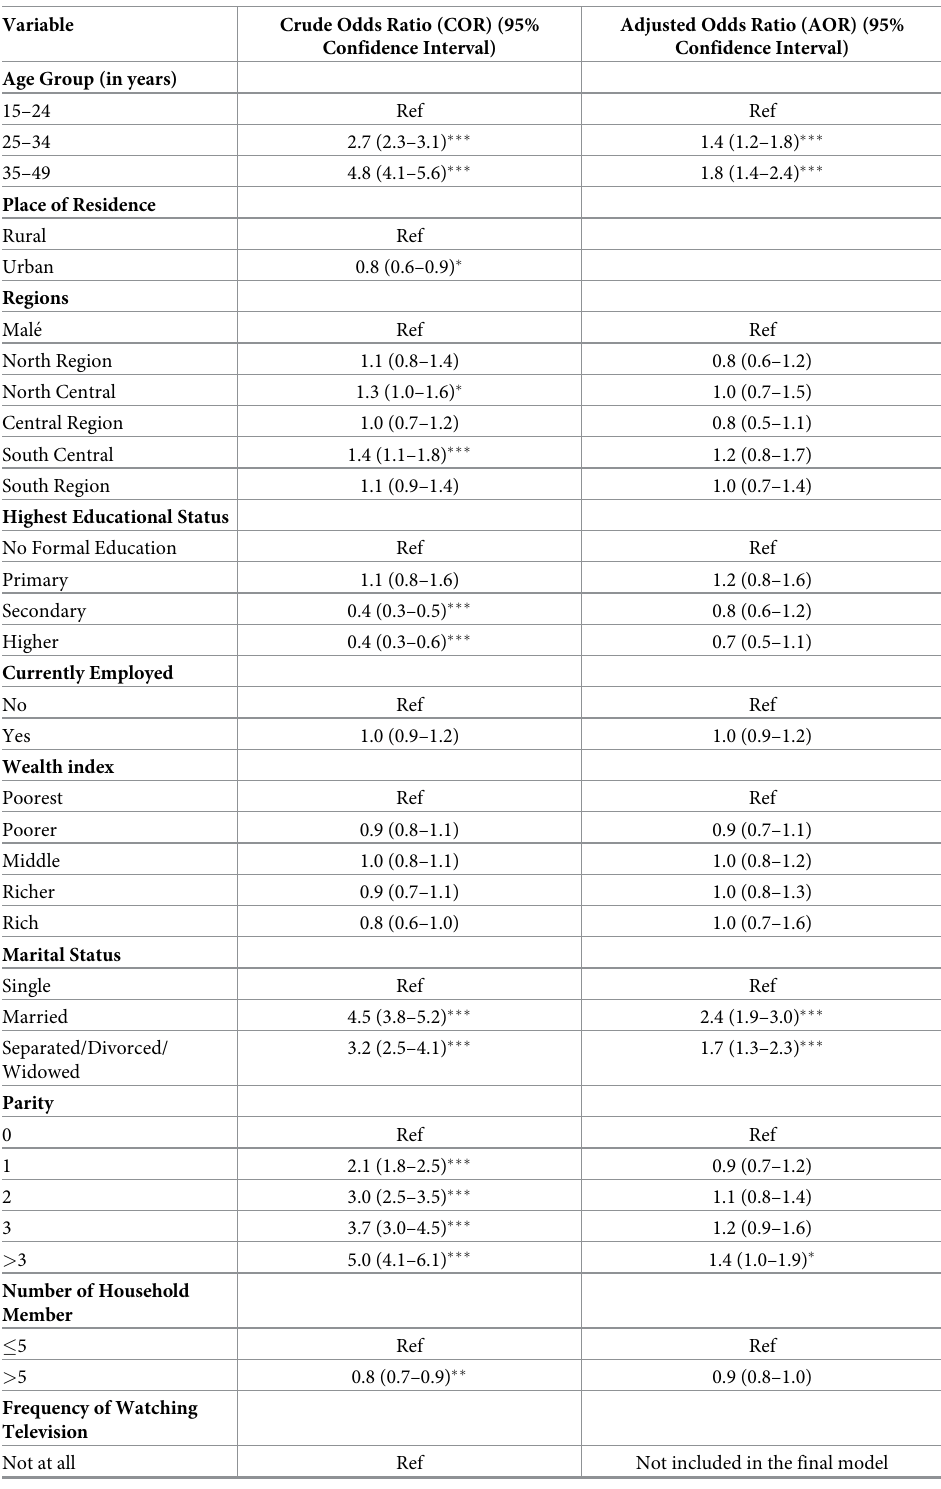
Table 3. Crude and adjusted odds ratio (95% CI) estimates of overweight/obesity compared to normal weight by respondent background